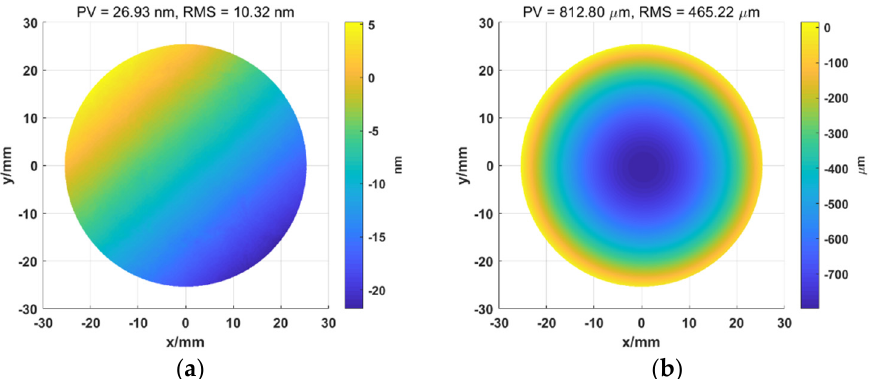
Figure 6. The reconstructed shape of specular objects through SPMD model. ( a ) The planar mirror with PV = 26.93 nm, RMS = 10.32 nm. ( b ) The concave mirror shape from reconstruction. PV = 812.80 μ m, RMS = 465.22 μ m.